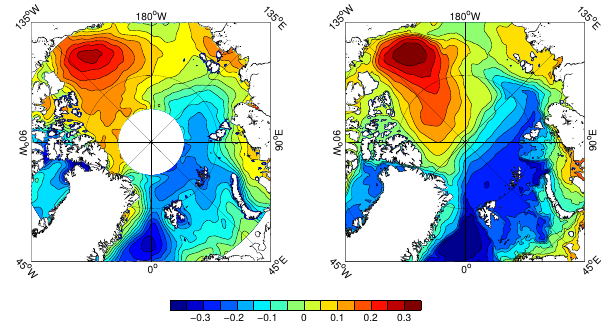
Figure 4. (Left) The estimated Arctic mean dynamic topography for the period 2003–2009, as described by Farrell et al. (2012). (Right) Modelled sea surface height (in metres) in the Arctic for the period 2003–2009 from hindcast